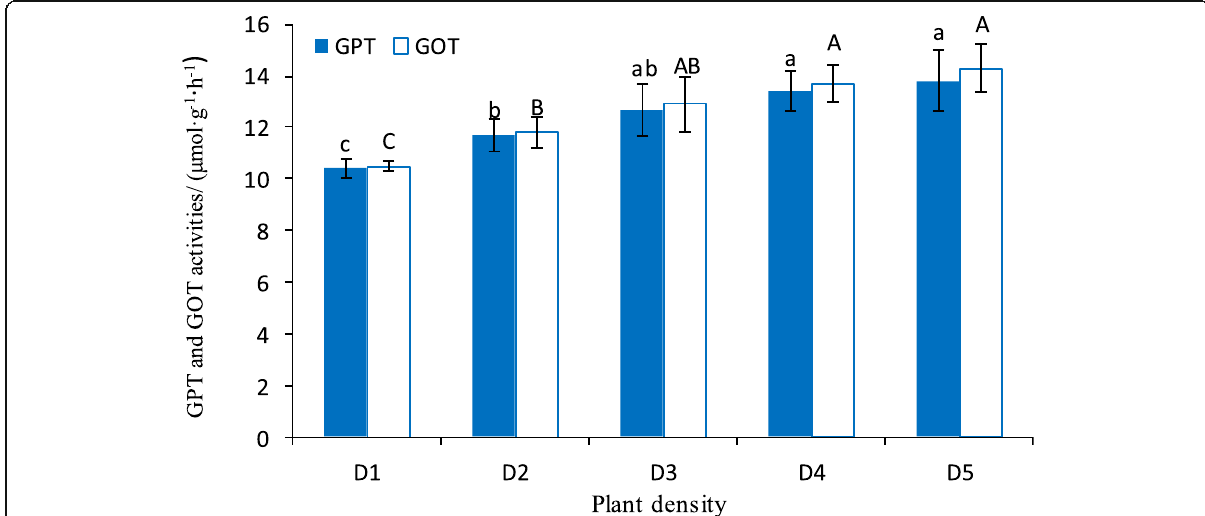
Fig. 3 The GPT and GOT activity in boll wall under different planting densities in 2017. D1-D5: 15 000, 25 000, 45 000, 60 000, and 75 000 plants per hectare. The vertical bar represents S.E. of the mean ( n = 3) when the value exceeds the size of the symbol. Lowercase letters indicate